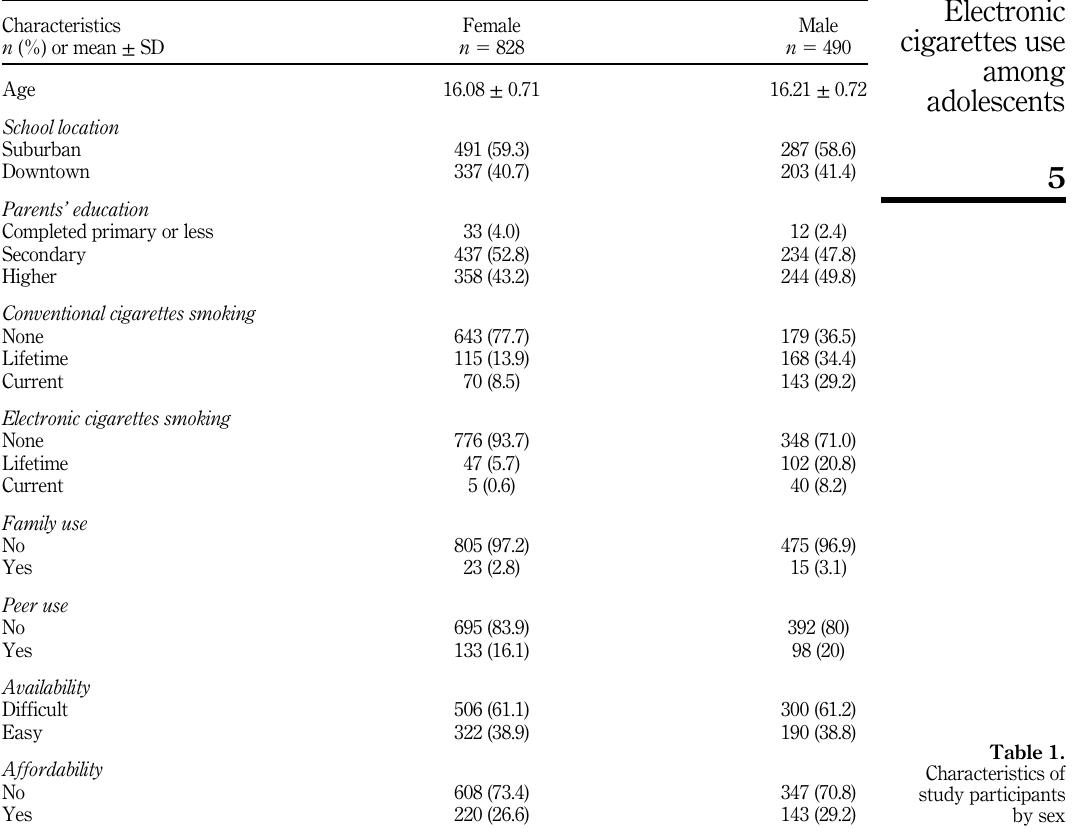
Table 1. Characteristics